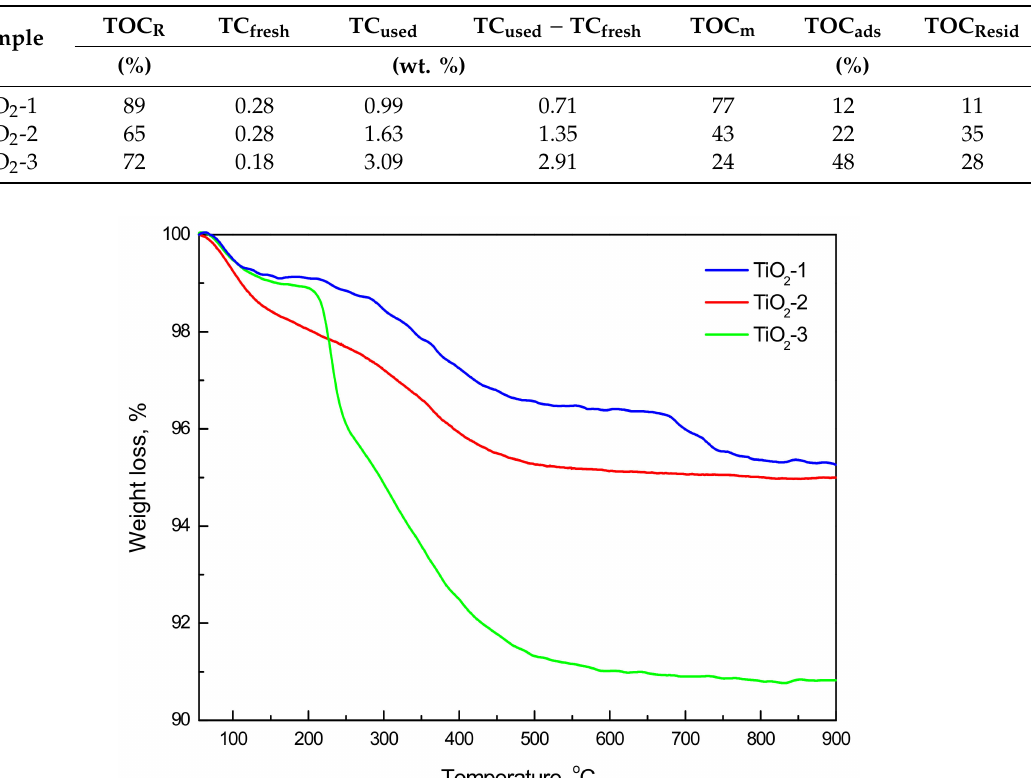
Figure 11. Thermogravimetric TGA-TPO analysis of catalyst samples after use in BPA degradation runs.